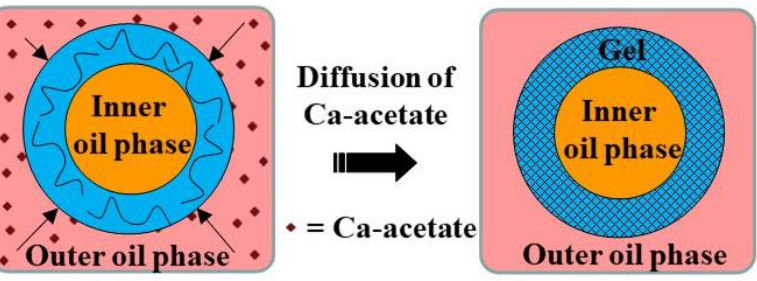
Figure 28. Fabrication of core−shell microgels with oil core and gel shell by external gelation of middle phase of O/W/O emulsion droplets. The gelation was triggered by diffusion of calcium acetate dissolved in the outer oil phase to the external droplet interface [115].